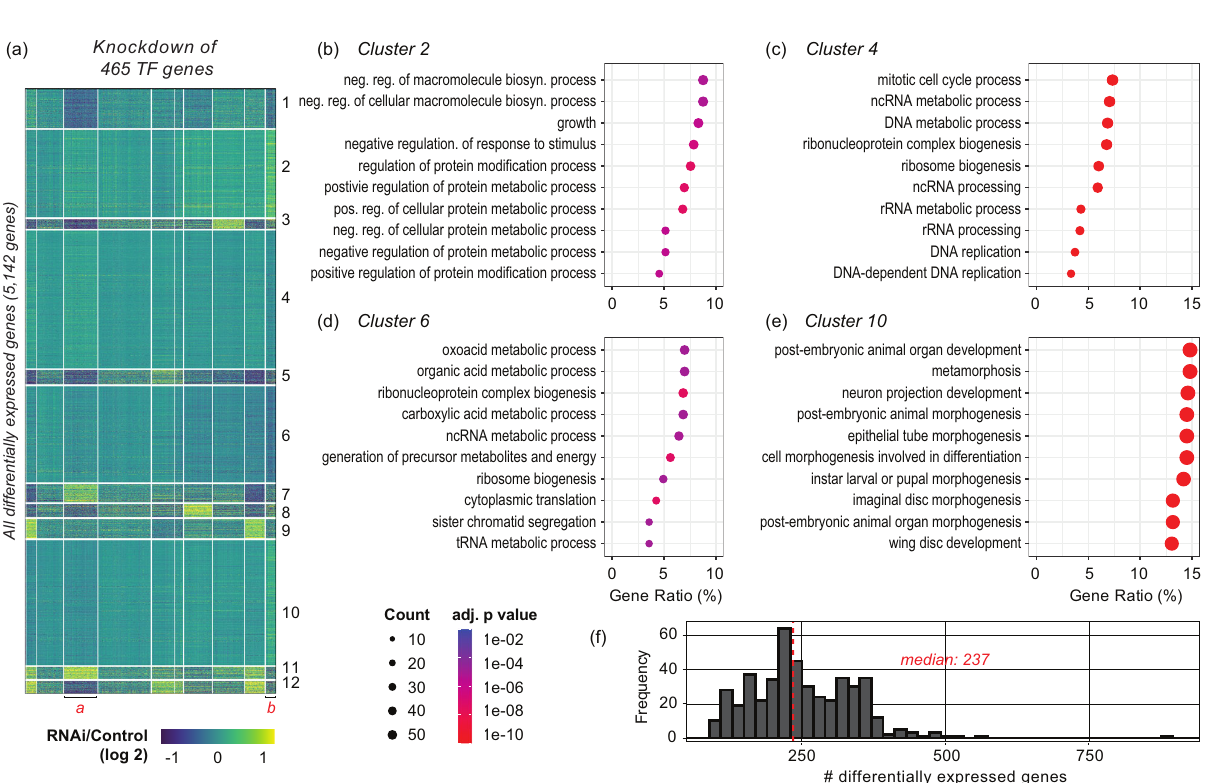
Fig. 3 Gene expression changes upon targeted knockdown of Drosophila TFs in S2 cells. a A heatmap summarizes differential gene expression between Drosophila S2 cells treated with TF RNAi versus control RNAi (dsRNA for E. coli LacZ gene). Columns. Depletion of 465 TFs. Rows. Gene expression changes in the log2 scale. Genes that are not differentially expressed from any of the TF RNAi experiments were not shown in this heatmap. The results are clustered using the k-means clustering method. b – e Results from Gene Ontology (GO) analysis for the clustered genes in ( a ). The four clusters with the largest gene sets are demonstrated. Circle size. A number of genes are associated with a speci fi c GO term or hits. Circle color. Adjusted p value. f A histogram that summarizes numbers of differentially expressed genes. Vertical red line. Median of the target TFs using the bathing method 45 . For the most of targets (452 out of 488), we used two different long dsRNAs and these were biologically duplicated to give four measurements per gene.